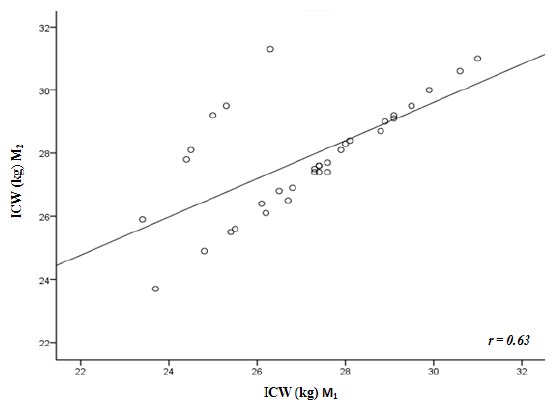
Figure 14. Correlation between the values of param- eters measured by Nutriguard-M before and after the intake of fluids – intracellular water